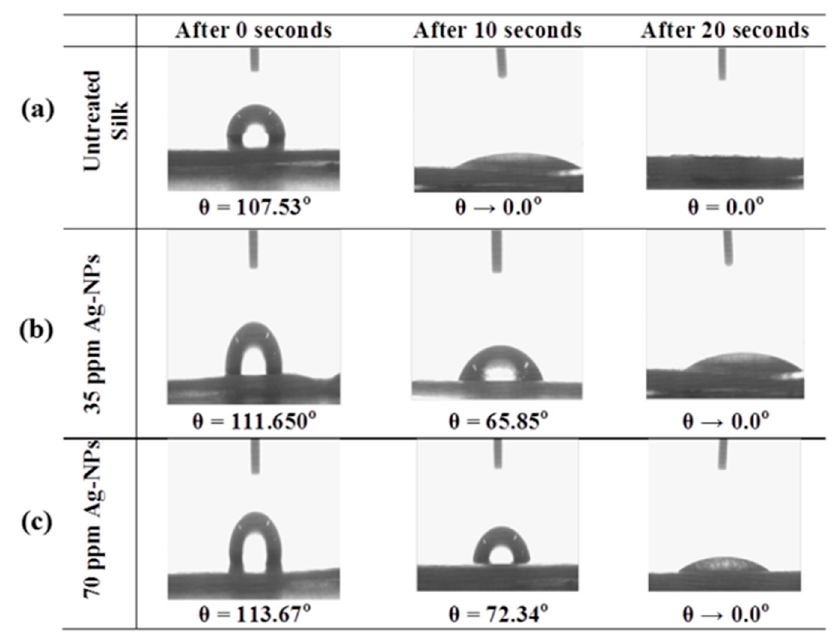
Figure 10. Water contact angles on the silk fabric surface, before and after washing.